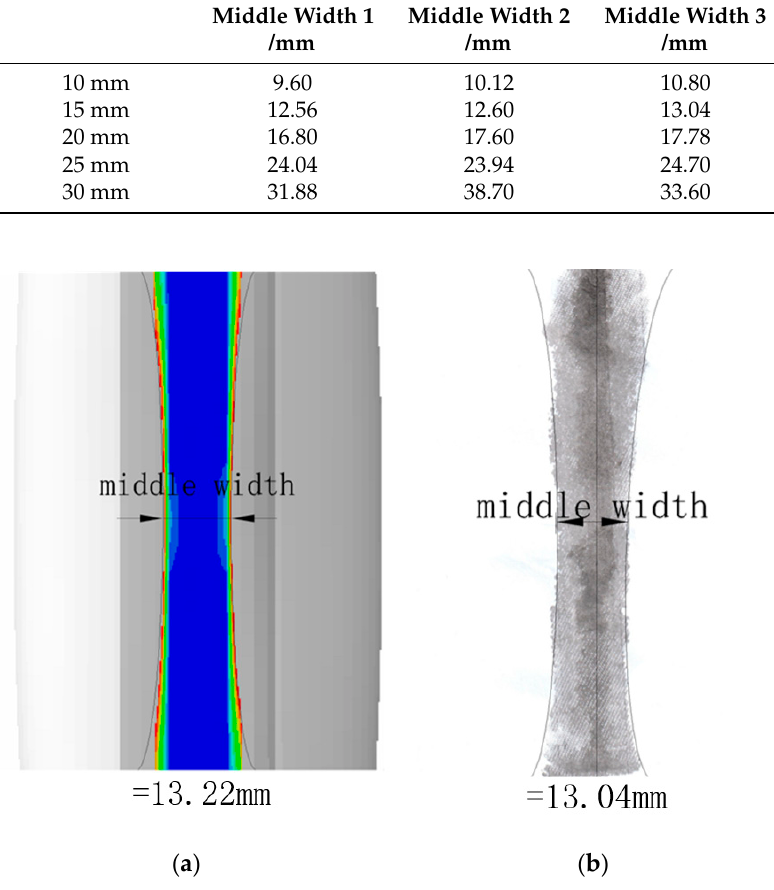
Figure 13. The simulation print ( a ) and the ink print ( b ) under pressing displacement of 15 mm.